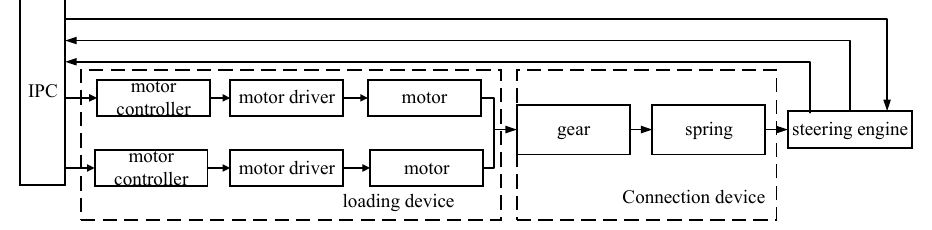
Figure 2. Dual-motor electric load simulator system structure.